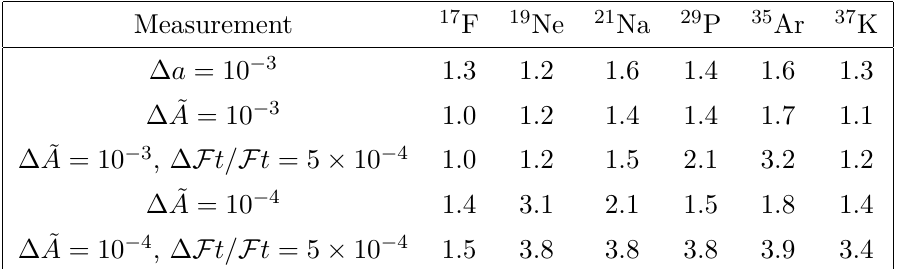
Table 7 . Potential improvements of the determination of the CKM matrix element V ud in the SM using only mirror decays with respect to the current extraction, V mirror row and column indicate the observable and transition, respectively, that is added to the current dataset. We remind the reader that an improvement of a 3.4 (1.8) factor is required to reach the current V extractions from superallowed (neutron) ud